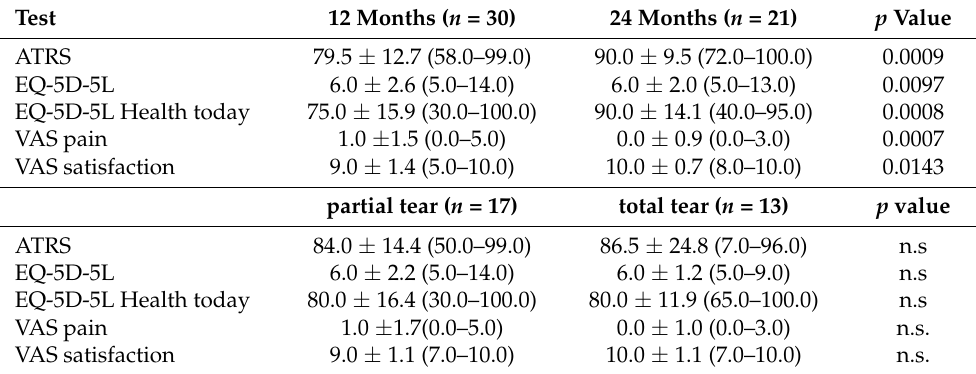
Table 3. The subjective outcomes of the surgical procedure.